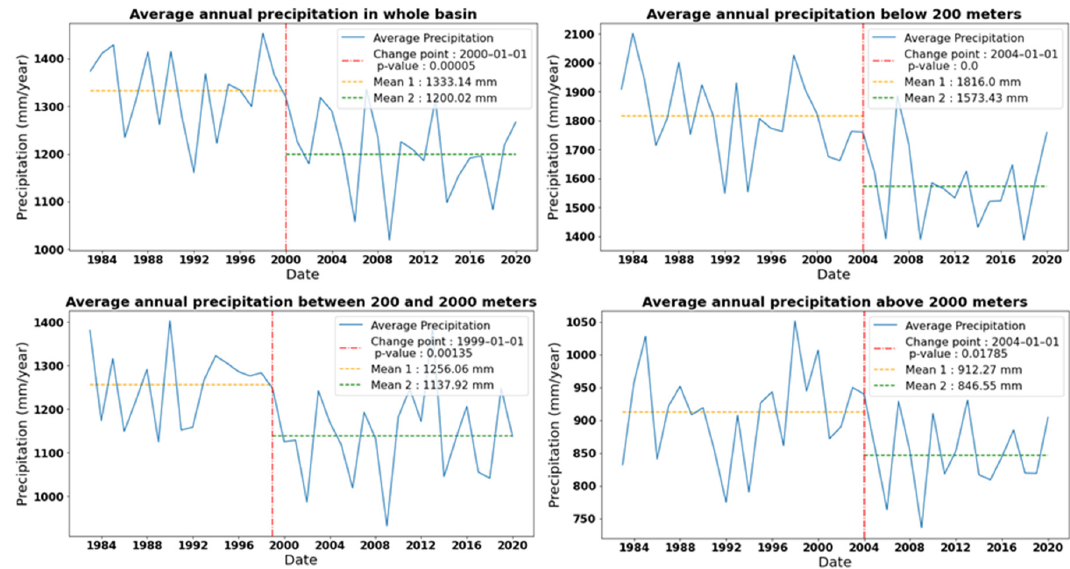
Figure 2. Change points in annual precipitation time series in whole basin and in three elevation regions.